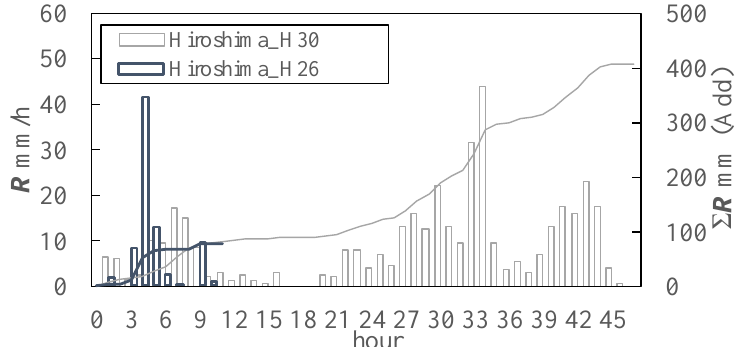
Figure 3. Heavy Rainfall in Hiroshima (H26, H30) [3].